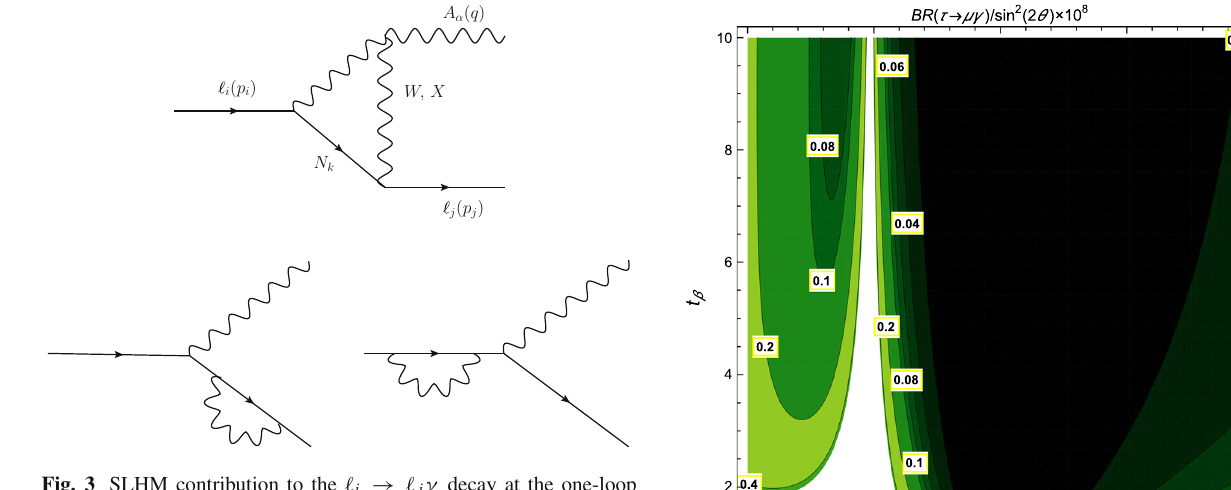
boson. The f ( x k ) function is presented in “Appendix C”.